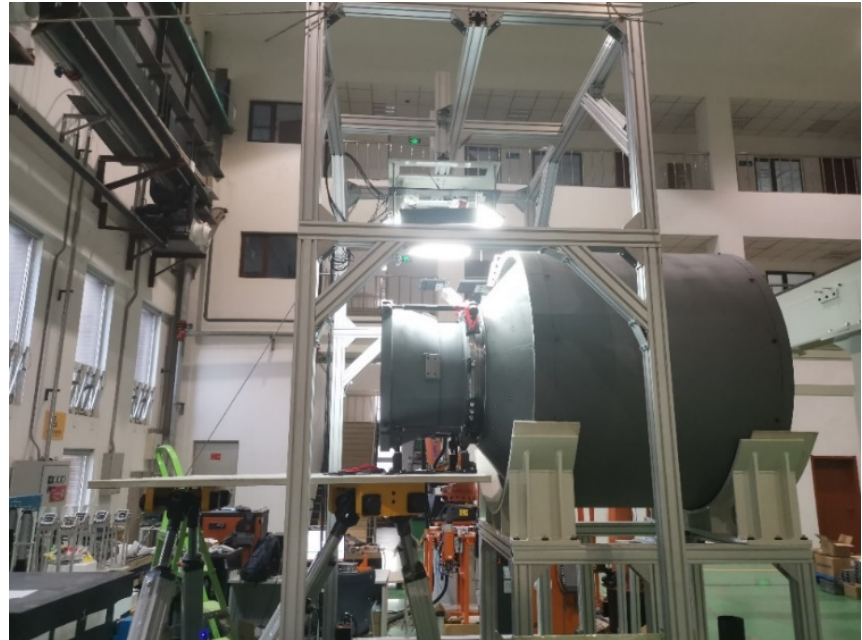
Figure 5. Experimental